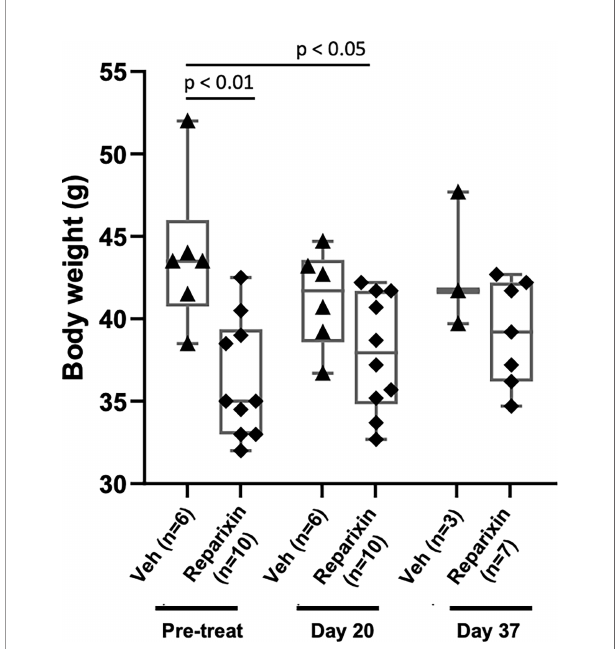
FIGURE 2 | Treatment with Reparixin did not affect animal weights. Body weight determinations performed before (Pre-treat) and after 20 or 37 days of treatment with Reparixin. Data are presented as box charts and as value per individual mouse (each symbol a different mouse). The data are normally distributed by Shapiro – Wilk test and the Reparixin pre-treatment (p < 0.01) and at day 20 (p < 0.05) group are statistically different from the vehicle group by Turkey ’ s multiple comparison